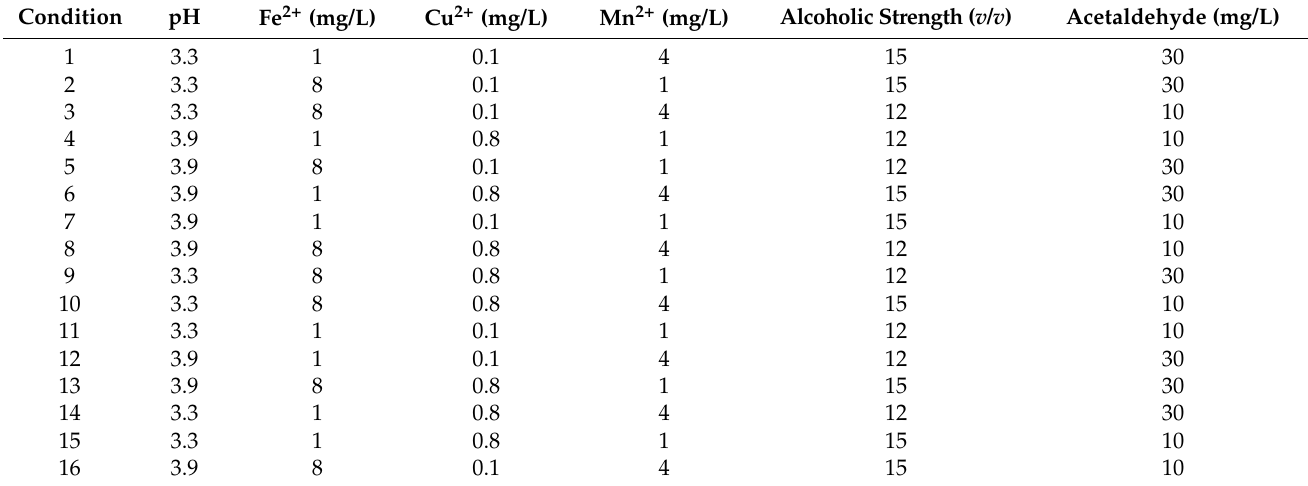
Table 1. The experimental conditions in L16 (2 15 ) Taguchi orthogonal array for the study the oxygen consumption potential of